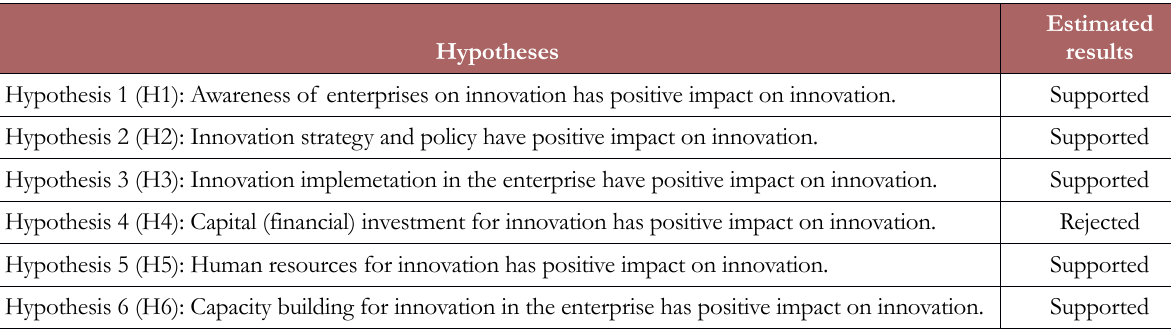
Table 6. Summary of hypothesis